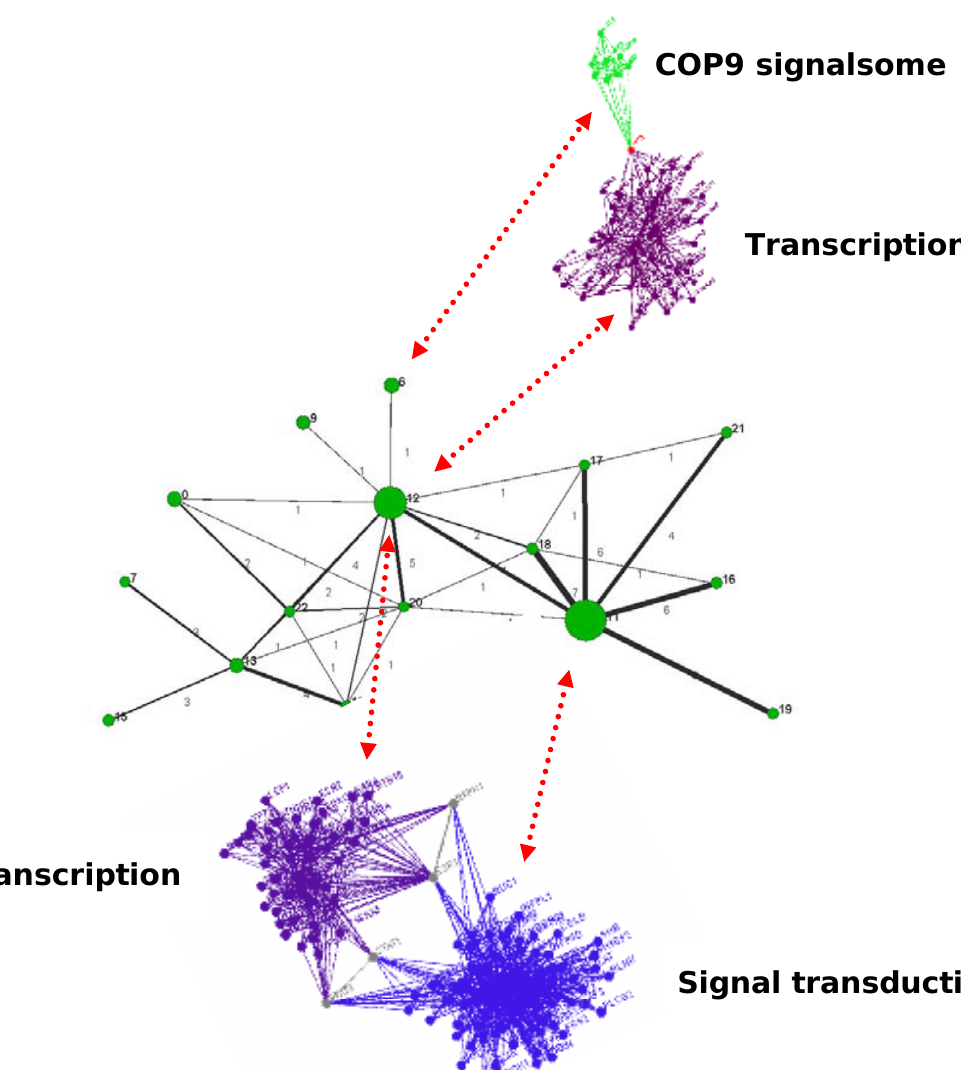
Figure 4: Network of modules. Nodes signify detected modules based on 6-cliques. The size of the nodes represents the number of proteins included in the corresponding modules. Edges between nodes indicate the existence of overlap. The width of the edges correlates with the number of linking